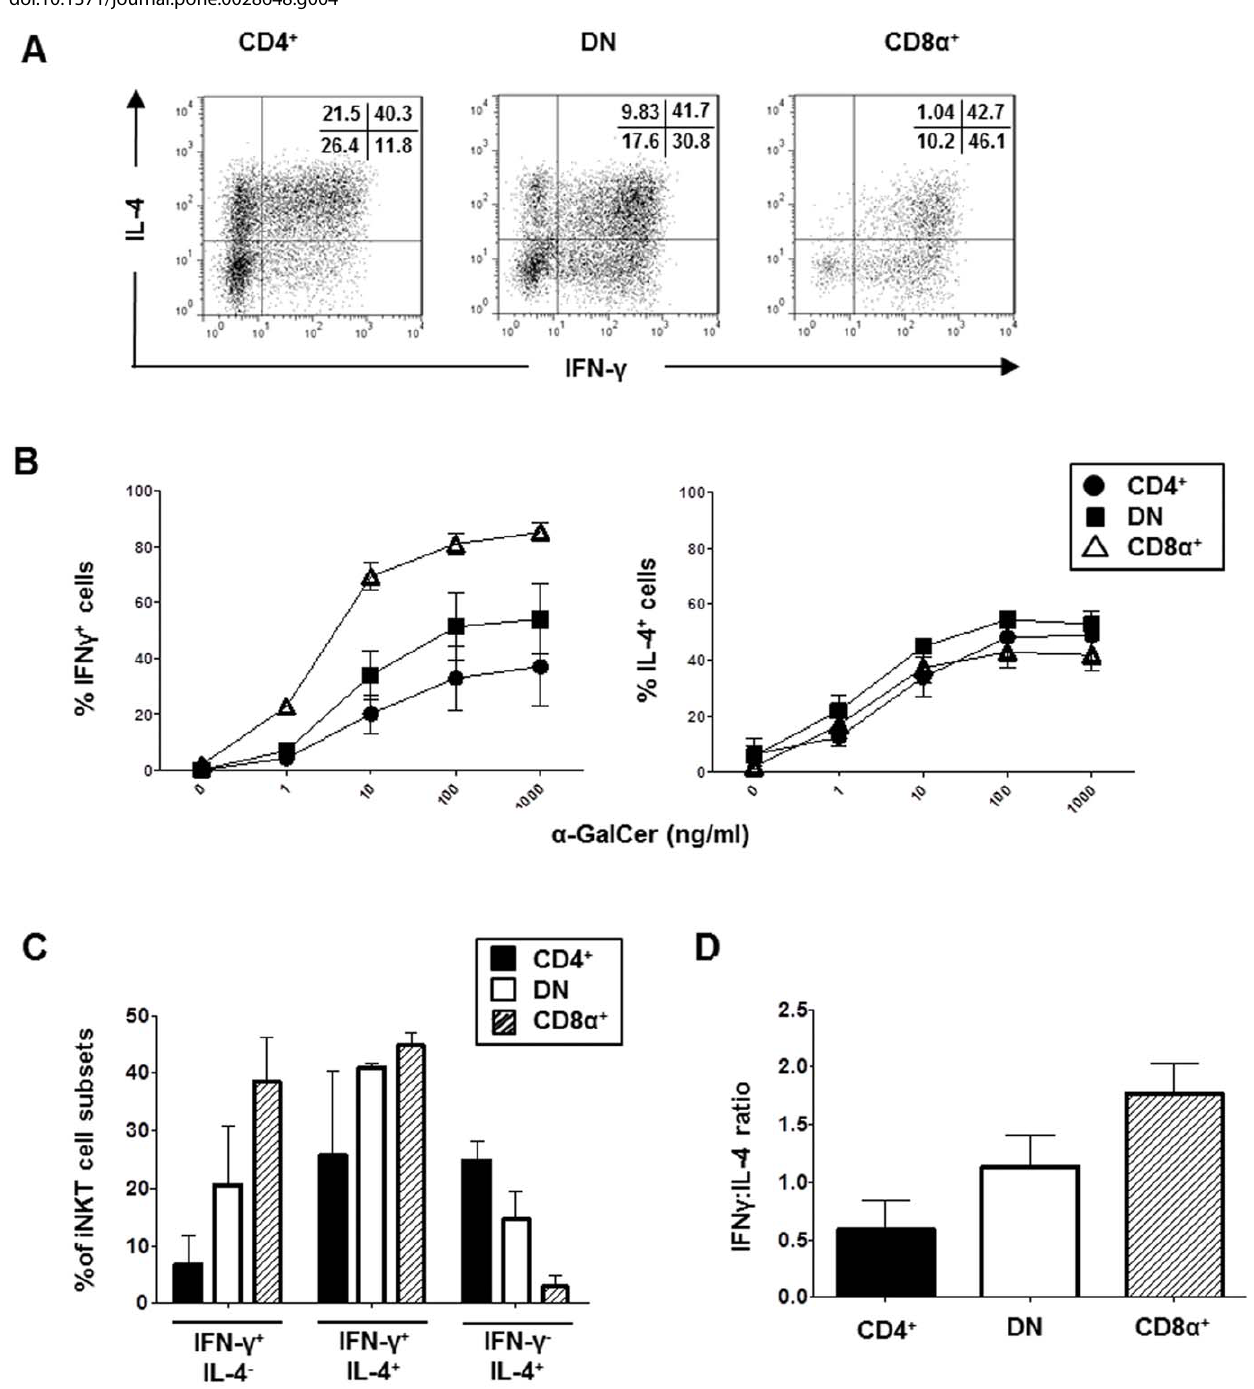
CD4 + , CD8 a + and CD4 2 CD8 a 2 iNKT Cells Figure 4. Cytokine secretion by iNKT cell subsets. Highly-purified populations of CD4 + , DN and CD8 a + iNKT cells were cultured in medium alone, with iDC or HeLa-CD1d cells in the absence or presence of 100 ng/ml a -GalCer, or with PMA and ionomycin for 24 hours. Levels of IFN- c , TNF a , IL- 1 b , IL-2, IL-4, IL-5, IL-6, IL-9, IL-10, IL-12p70, IL-13, IL-17a and IL-22 in cell supernatants were measured using the FlowCytomix Multiplex kit. Results show mean ( 6 SEM) cytokine levels in experiments involving iNKT cell lines from 3 healthy donors. p values in shaded boxes show Kruskal-Wallis comparisons of cytokine levels released by CD4 + , CD8 a + , and DN iNKT cells; * p , 0.05 comparing CD4 + and CD8 a + iNKT cells using post hoc Dunn’s test.